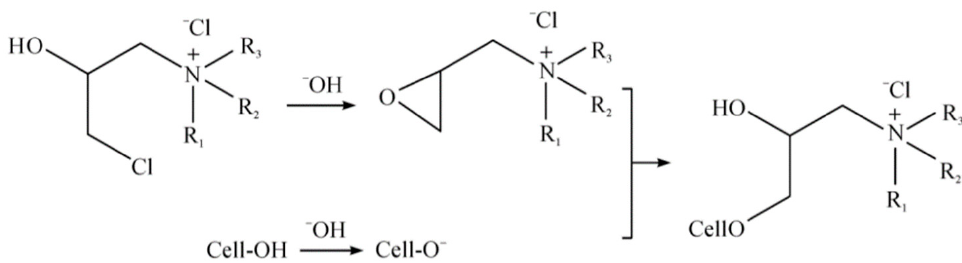
Figure 2. The reaction process of modifying the cellulose.